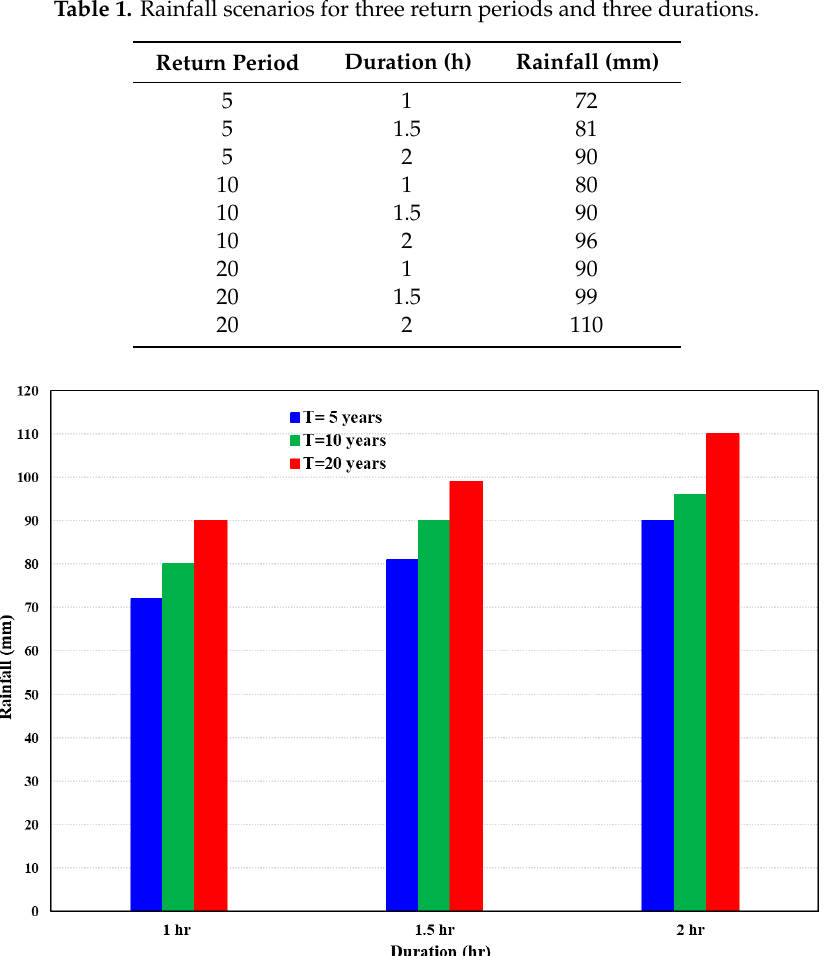
Figure 3. Rainfall scenarios for three return periods, namely 5, 10, and 20 years.